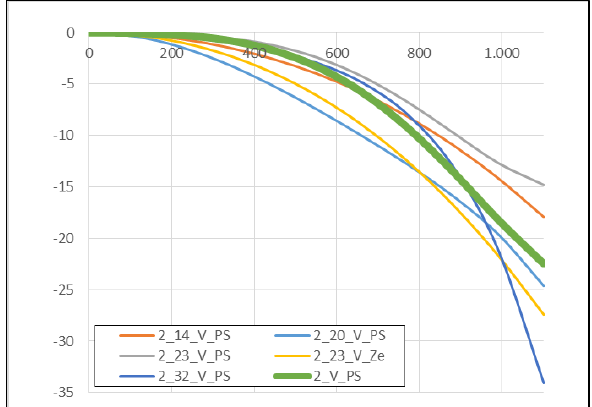
Figure 10. Estimated curves of radial distortion for video